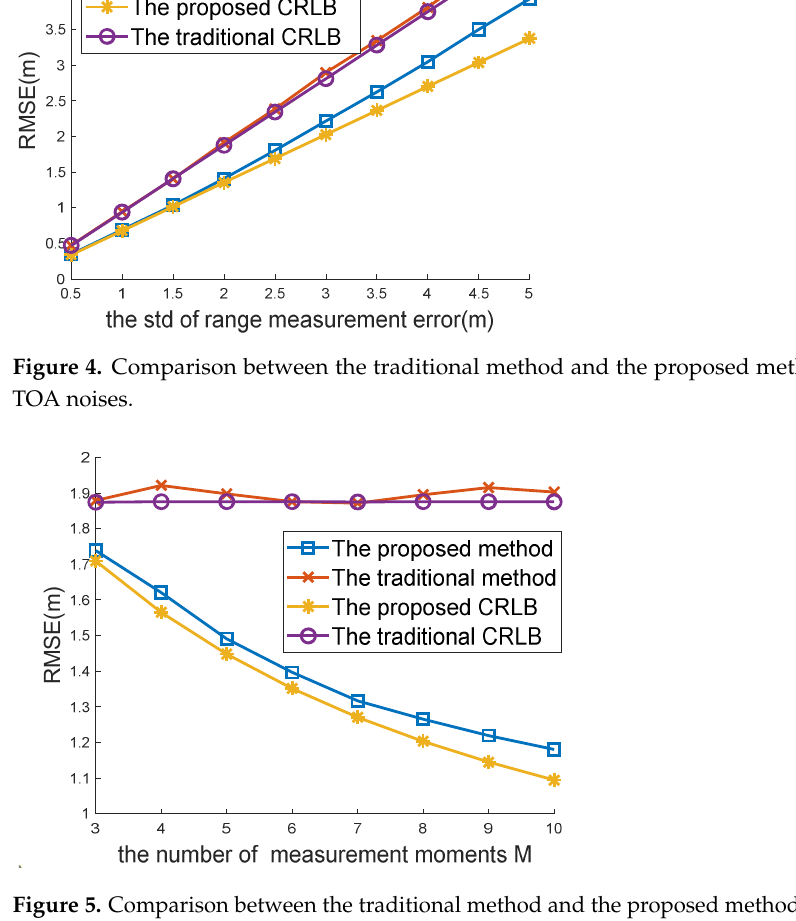
Figure 4. Comparison between the traditional method and the proposed method under different TOA noises.